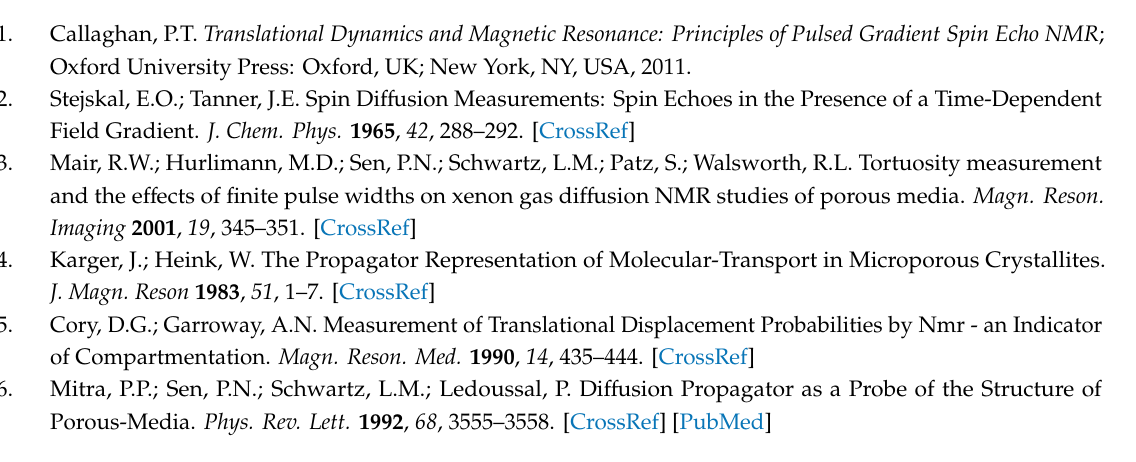
B 0 + G z z Figure 7. Scheme of the diffusion probe used in the study. The probe used the Maxwell pair type of a gradient coil and a solenoidal RF coil in the gradient coil center. In the RF coil, a glass tube containing the sample was inserted. The magnetic field gradient of the probe was perpendicular to the axis of the glass tube containing the